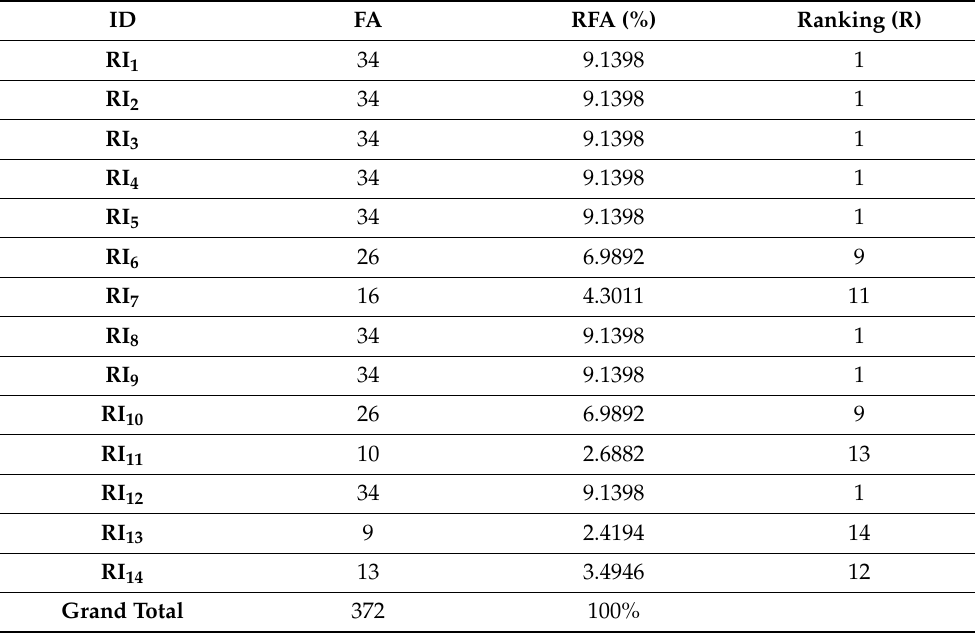
Table 4. Relative frequency of appearance and ranking of the readability